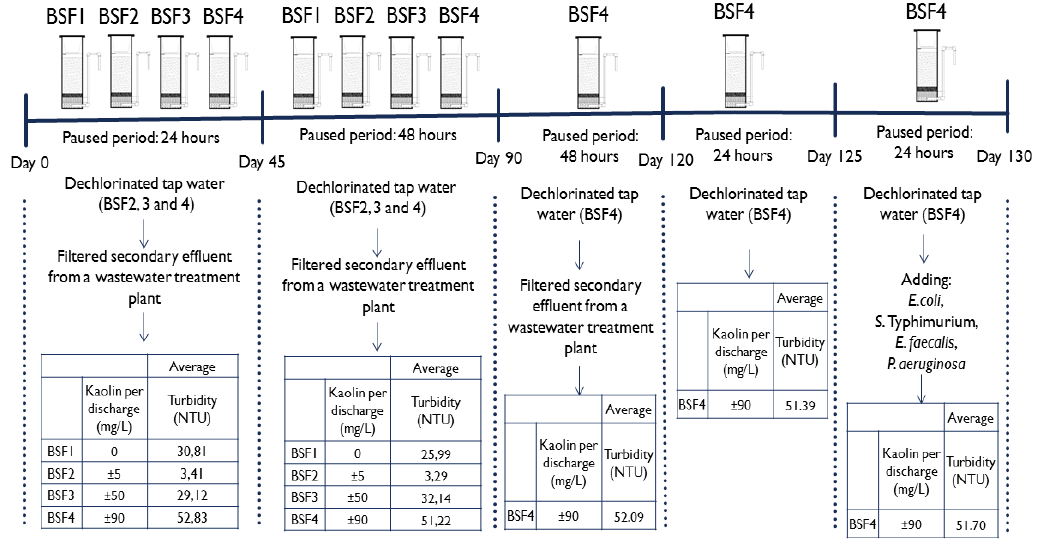
Figure 2. Experiment timeline and influent water preparation.